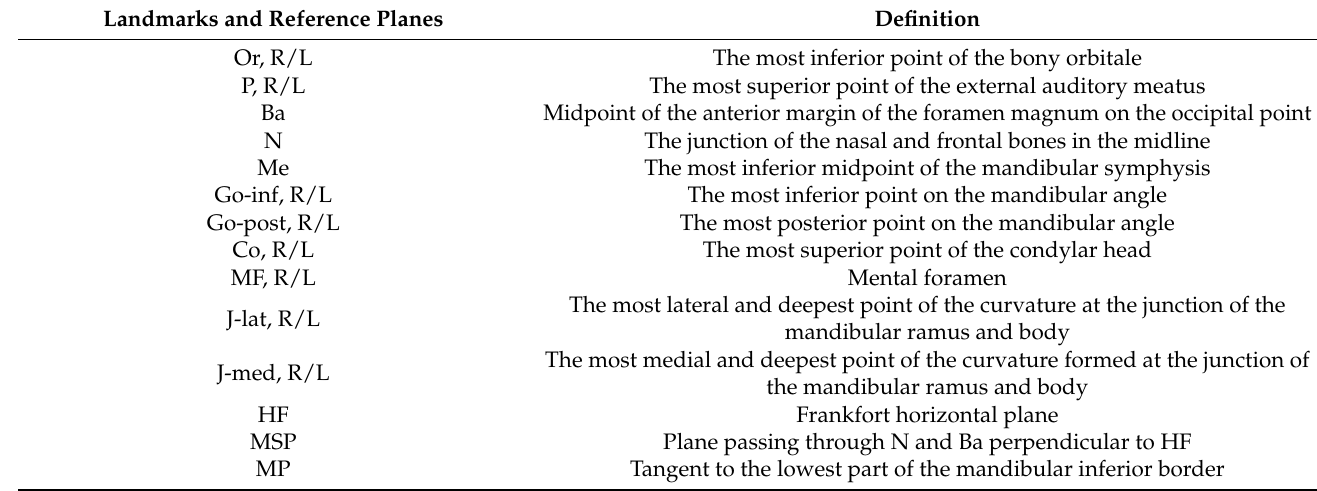
Table 1. Definition of the selected landmarks and reference